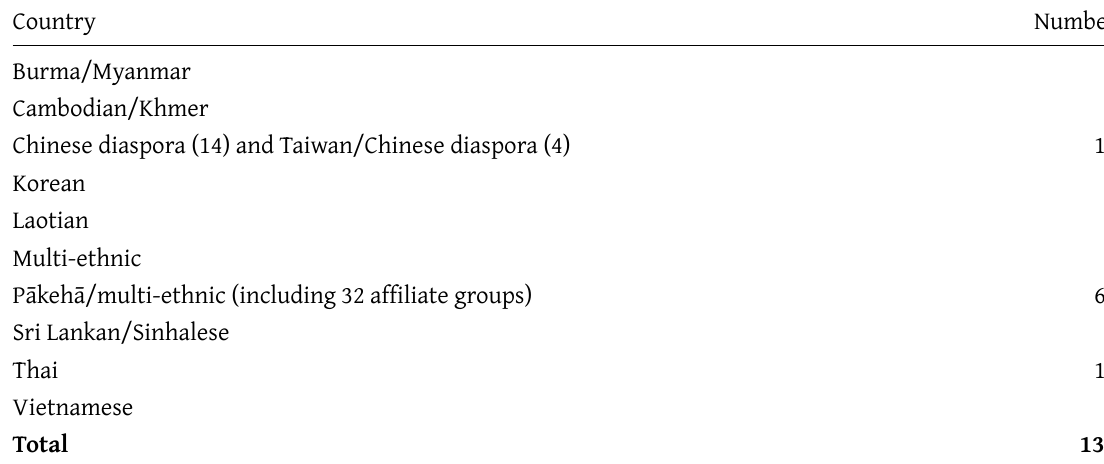
Table 6: Buddhist Organizations according to National Origin,